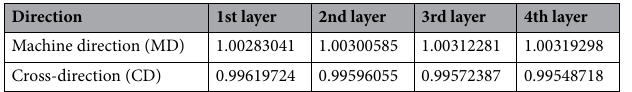
Table 2. The scale factor for passive compensation control of registration.